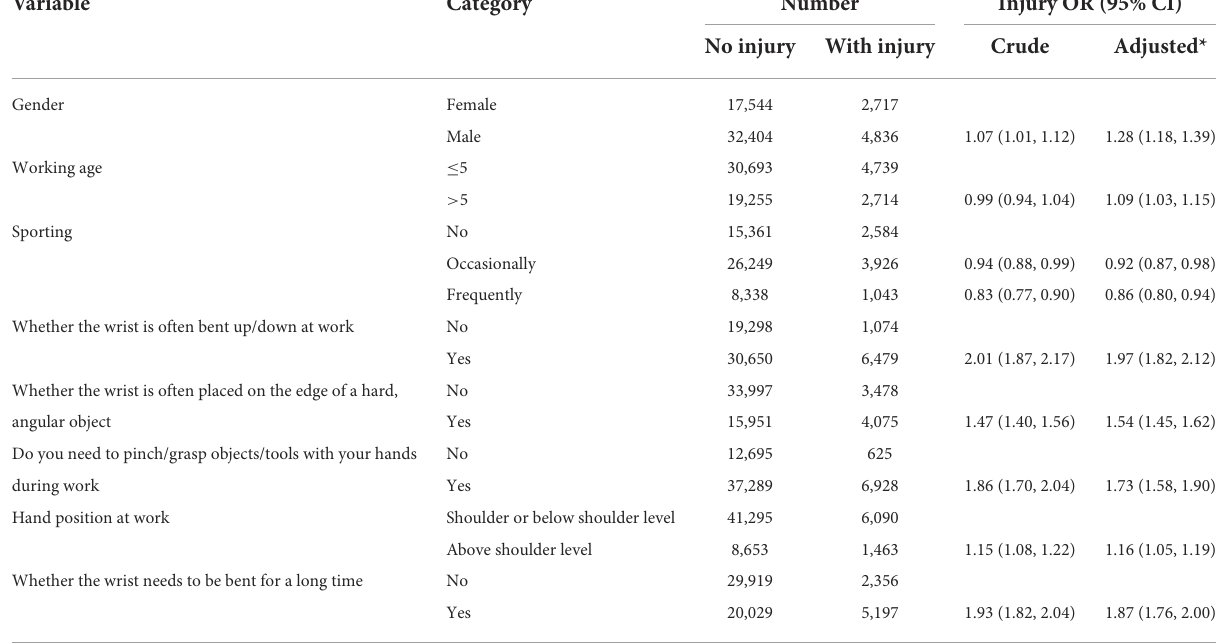
TABLE 6 Results of binary logistic regression analysis of associated factors of wrist injury.